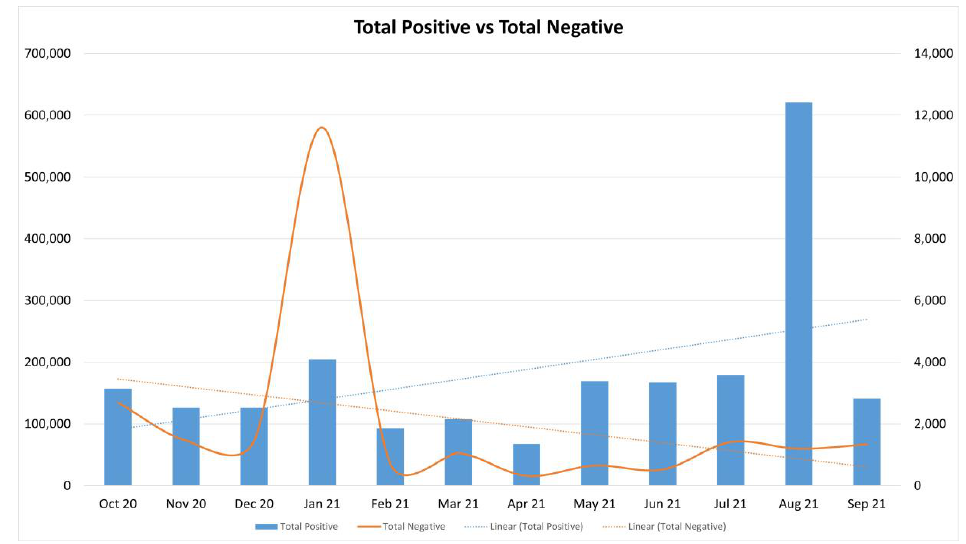
Figure 3. Total Positive reactions vs. Total Negative reactions on Facebook page and group message posts with trend lines.